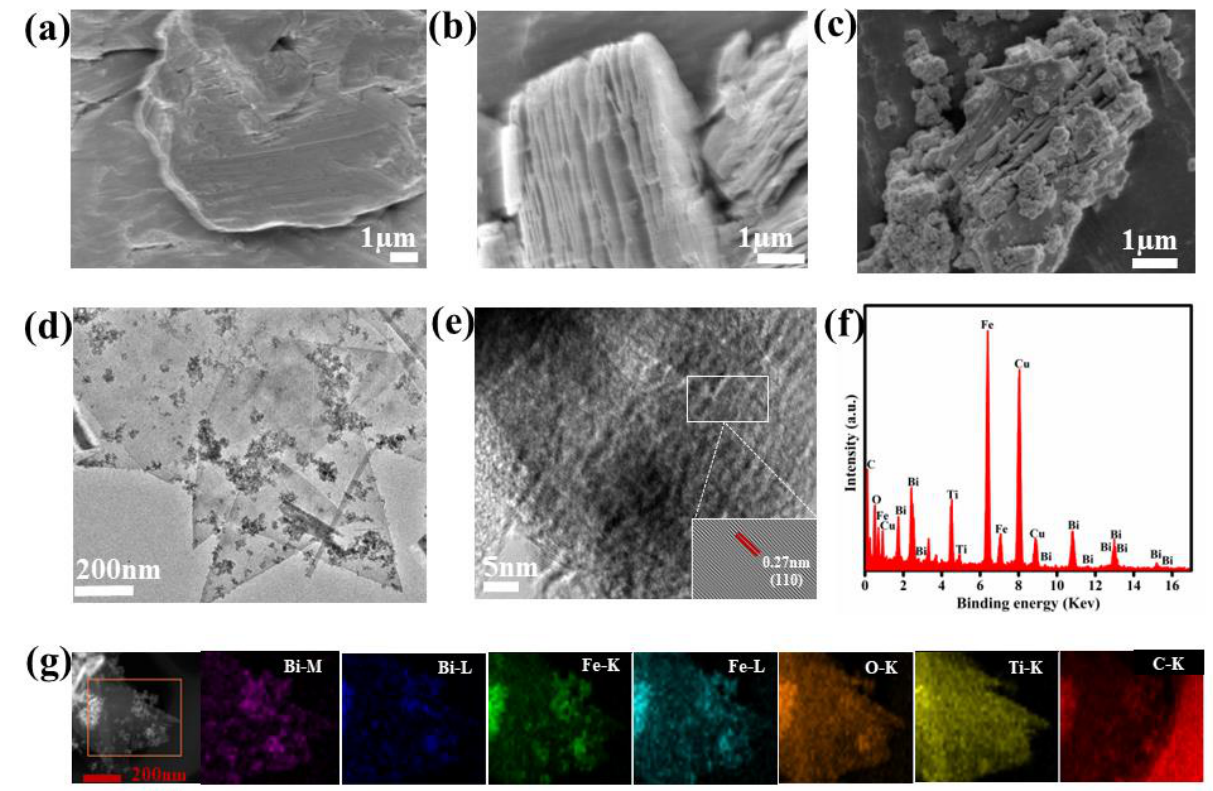
Figure 2. SEM of ( a ) MAX phase, ( b ) MXene, and ( c ) BiFeO 3 /MXene ( d ) TEM, ( e ) HR-TEM, ( f ) EDX spectrum, and ( g ) mapping images of BiFeO 3 /MXene.